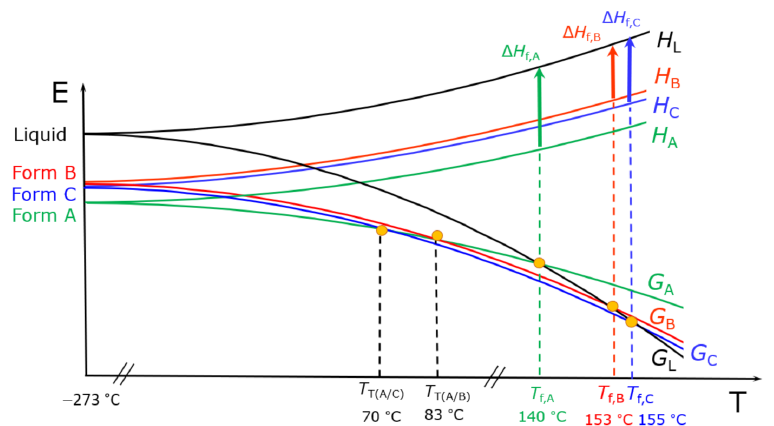
Figure 6. E/T (energy vs. temperature) diagram showing the complex phase relationship between the three unsolvated, non-hygroscopic crystalline forms, designated as form A, form B, and form C of Bitopertin. Figure adapted from